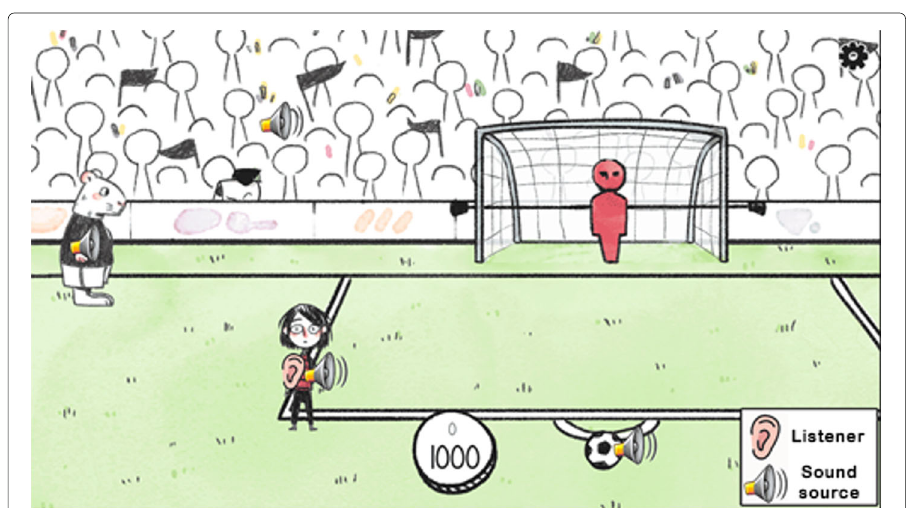
Fig. 2 Football Pitch stage with indication of the listener’s position and all the scenario sound sources